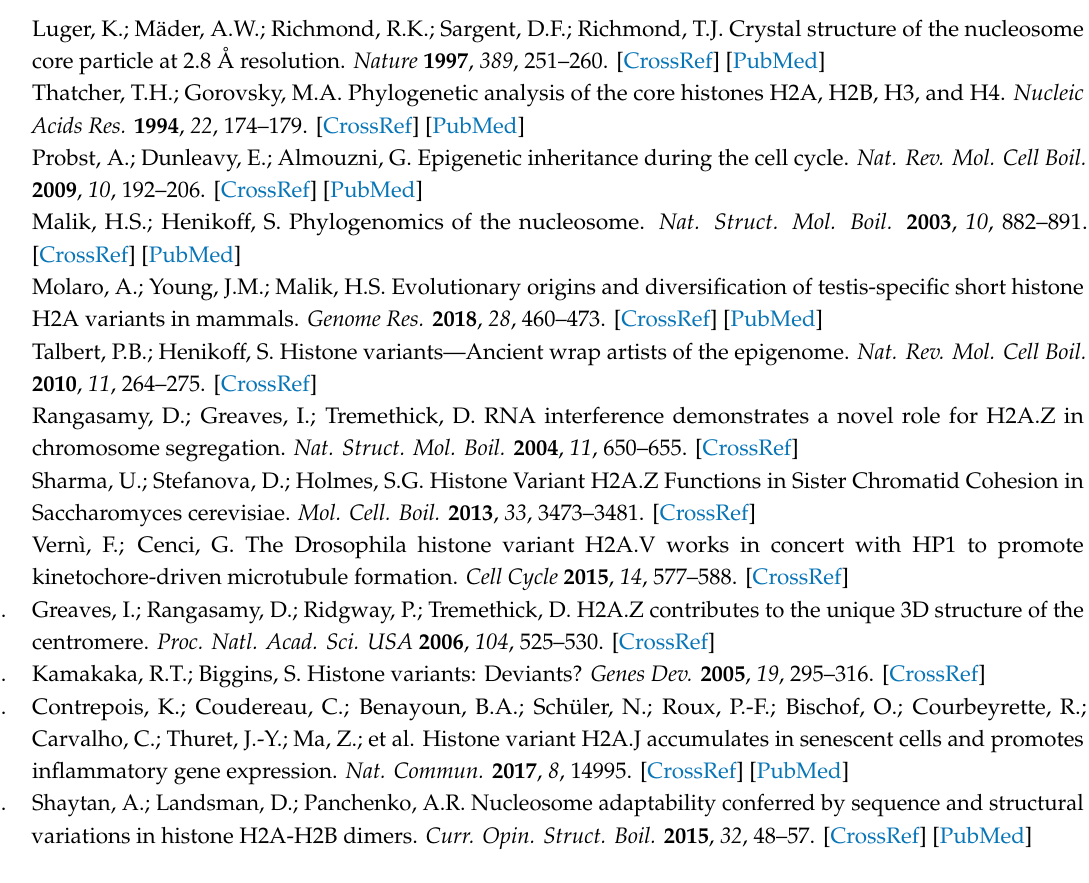
Figure 3; T.A.S.; writing—review and editing, D.J.T.; writing—review and editing; T.A.S. funding